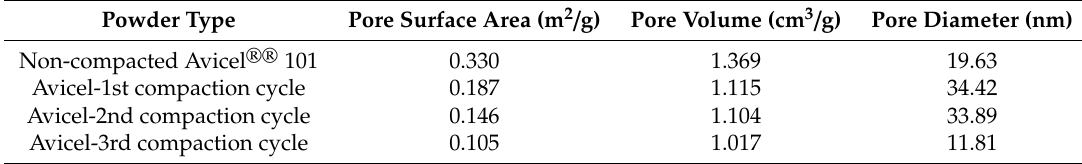
Table 1. Porosity characteristics of non-compacted and compacted Avicel ®® PH-101.